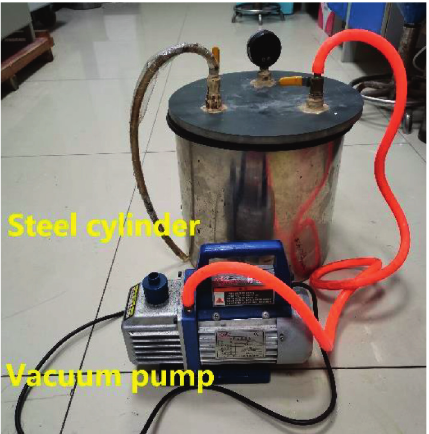
Figure 9: Vacuuming device.